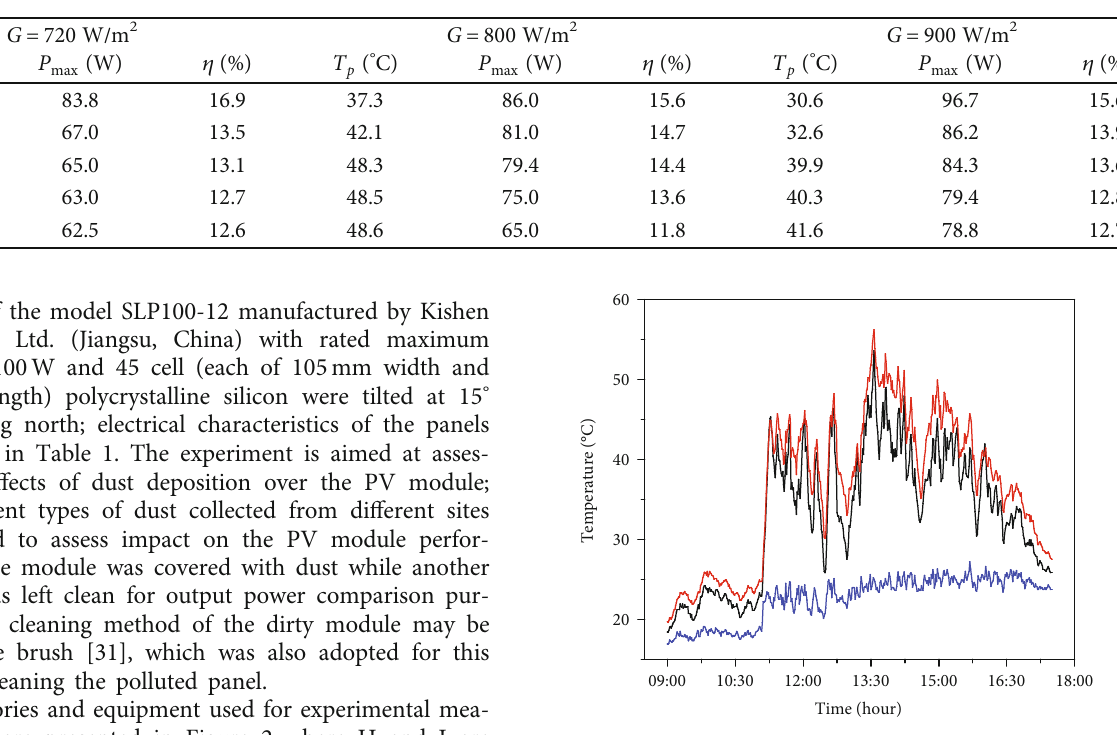
Figure 5: Weather parameter data taken at the site. Table 2: Temperature e ff ect on a clean module performance.